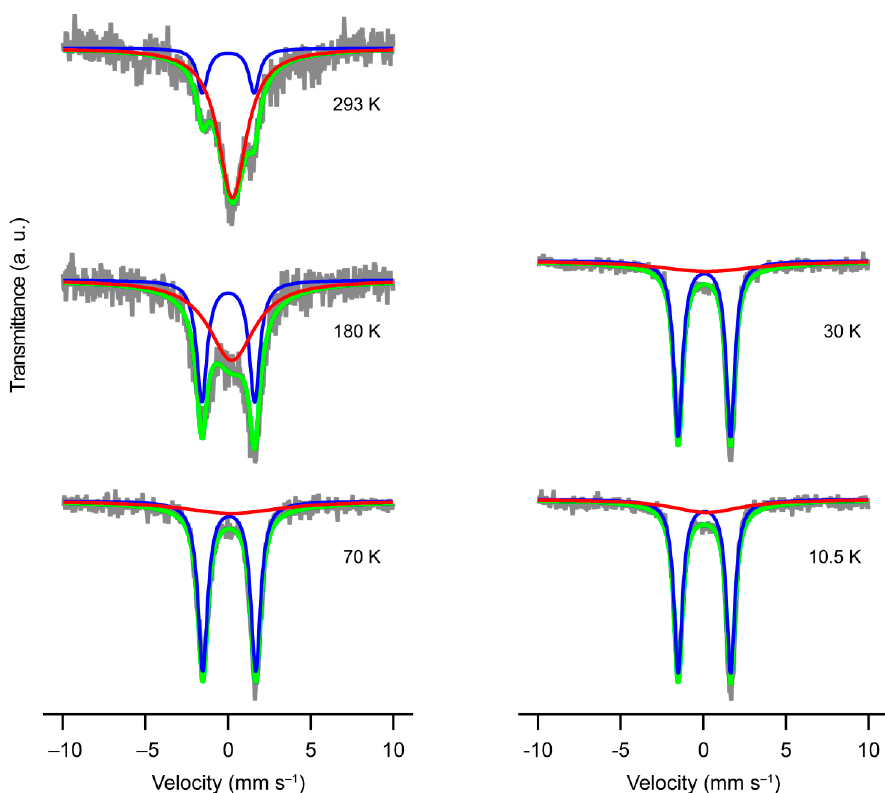
Figure 4. Temperature dependence of Mössbauer spectra for 1 . Gray lines are observed spectra. Red and blue lines indicate the simulated HS and LS spectra, respectively. Green lines are the sum of the simulated HS and LS spectra. Table 1. Temperature variations of Mössbauer parameters for 1.